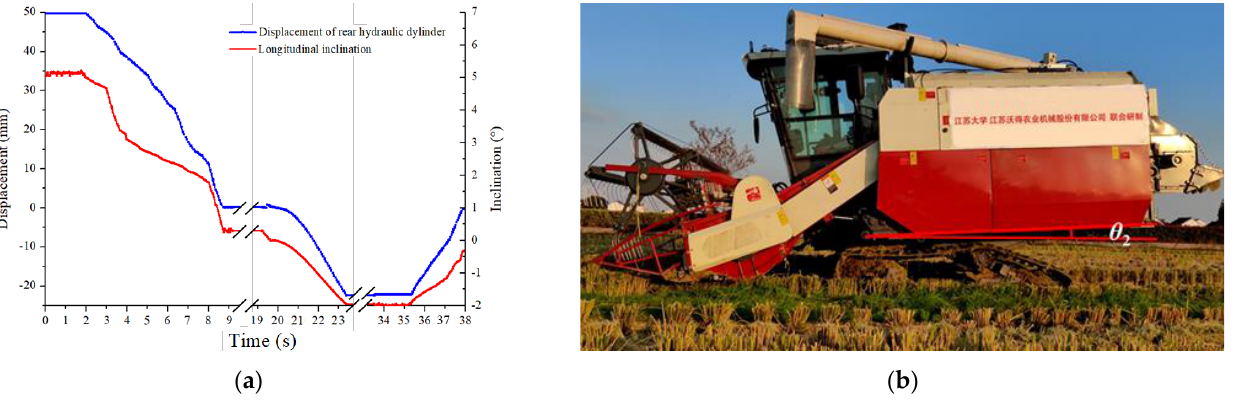
Figure 14. Vehicle longitudinal leveling test of combine harvester. ( a ) Vehicle leveling after tilting longitudinally. ( b ) Vehicle longitudinal leveling test in the field.